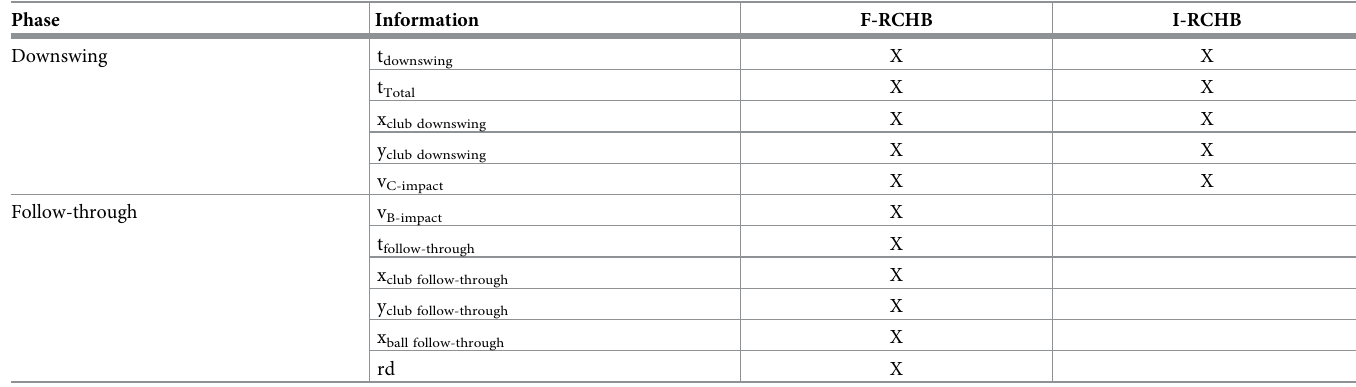
Table 5. Comparison of available spatio-temporal information under full (F-RCHB) and incomplete (I-RCHB) vision condition. Phase Information F-RCHB